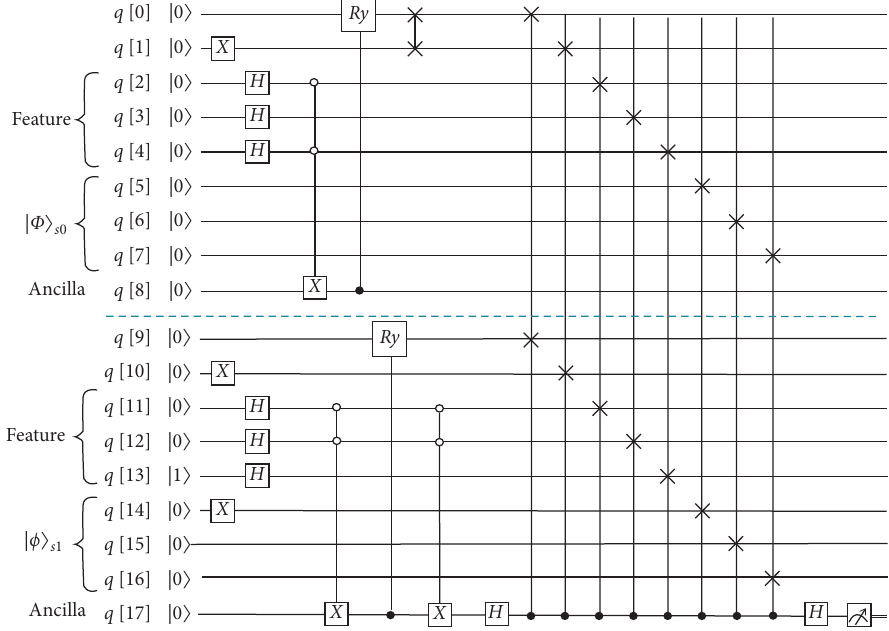
Figure 9: One of the ideal experiment circuits of similarity calculation in QReliefF algorithm running on Rigetti platform. q[0] − q [7] represents the randomly selected quantum state | ϕ 〉 S and Ry is R y operation which can be expressed as a matrix in equation